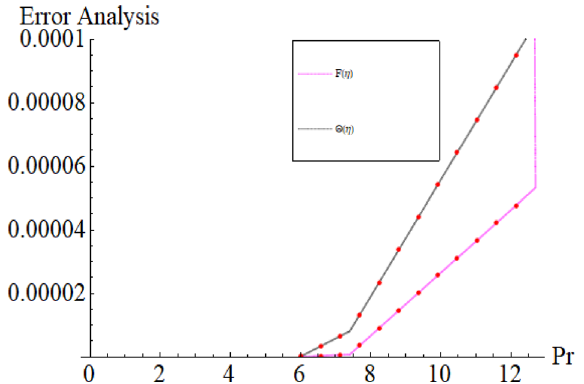
Figure 21. Impression of the parameter Pr range.